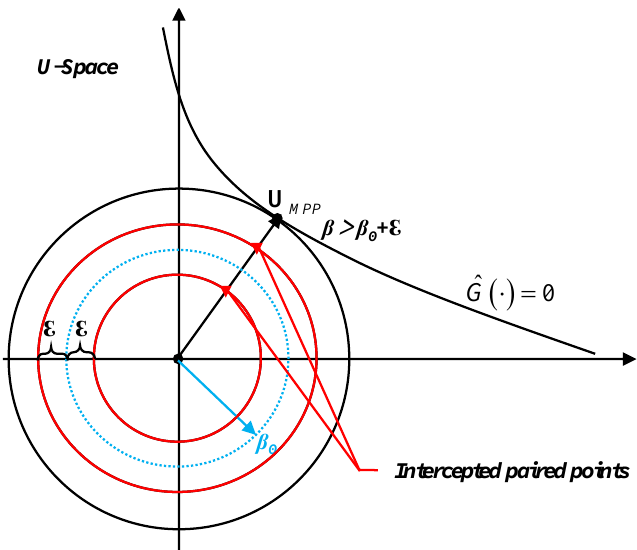
Figure 3. Intercept paired training samples according to the MPP. Based on the reliability index of the sample x , the interception of the lower incremental sample P − is classified into three cases, as shown in Equation (8):